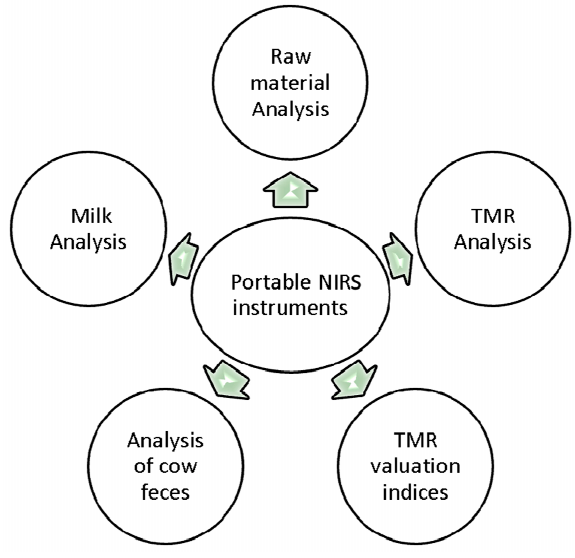
Figure 1. Schematic representation of portable NIRS instruments use in dairy farms.